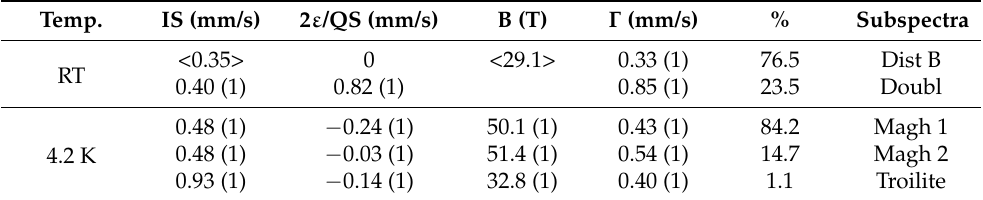
Table 5. Mössbauer parameters obtained from the fitting to the spectra shown in Figure 16. The errors in the last digit are given in brackets.